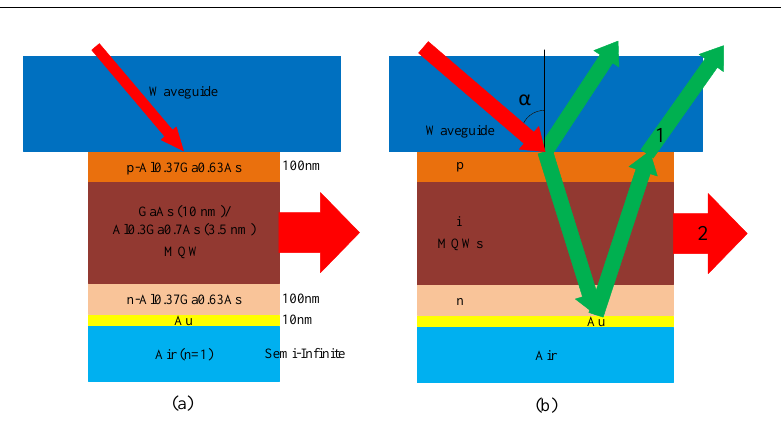
Figure 7. ( a ) The structure of the electronic section for the use of TE polarization. ( b ) The electronic section of a PhC-based ERM into which incoming light enters at an alpha angle and undergoes two possible events: (1) green arrows denote reflected light from the electronic section to the waveguide region, or (2) a red arrow in the intrinsic region of the p-i-n diode denotes absorbed